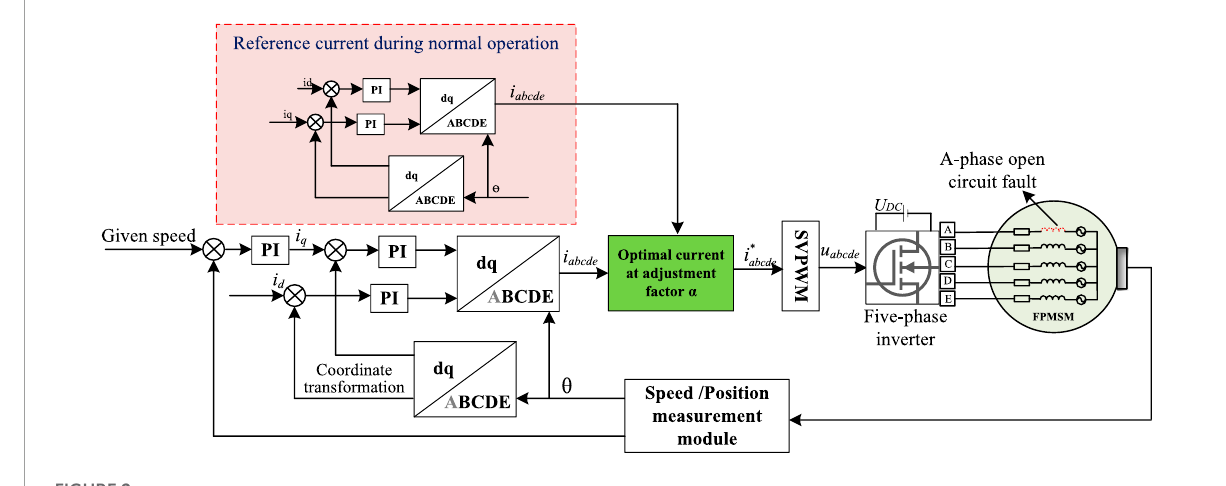
FIGURE 2 Block diagram of system control applying fault-tolerant control